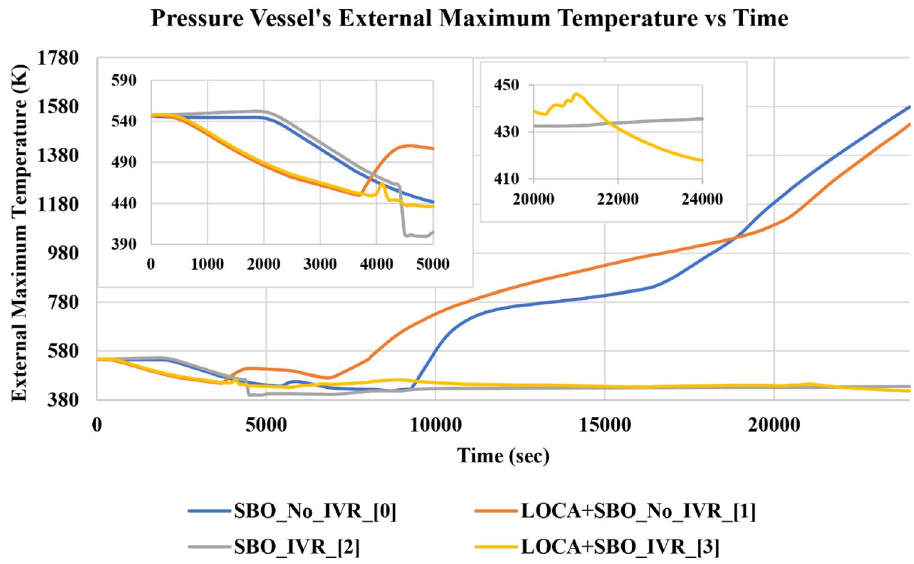
Figure 1. Pressure vessel’s external maximum temperature vs